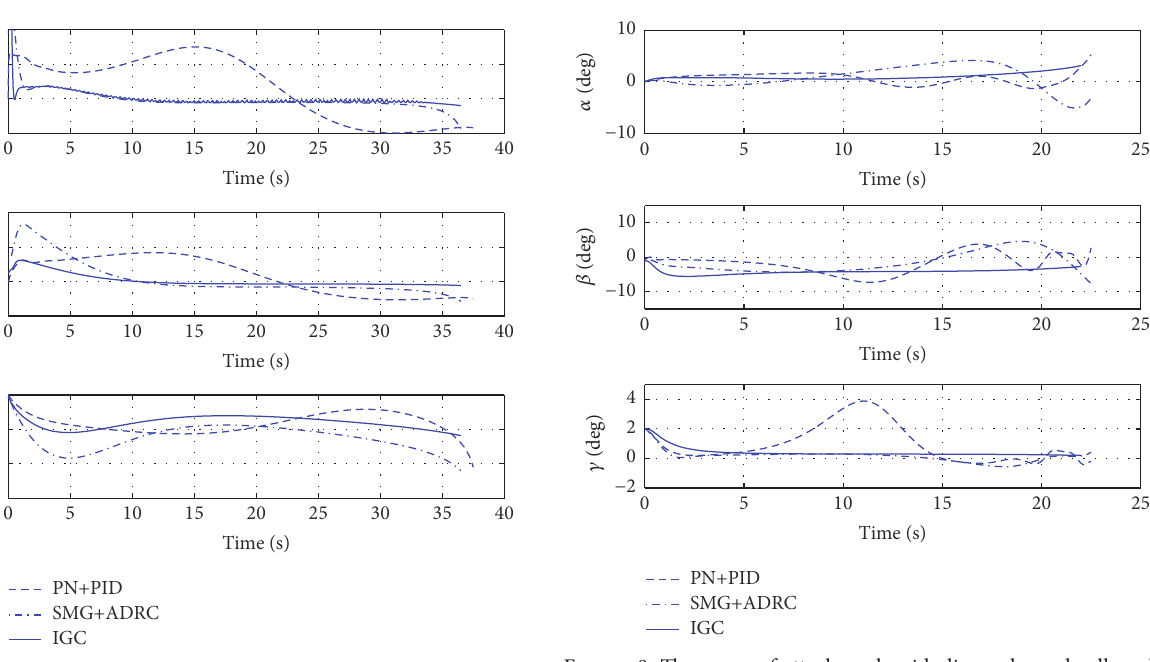
Figure 6: The range of deflections of aerodynamic fins with respect to time in Scenario 1.